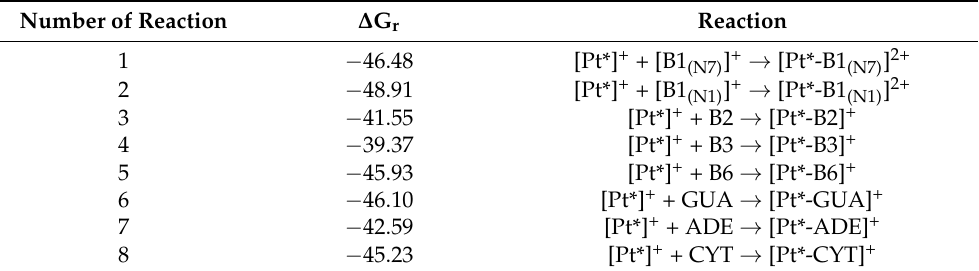
Table 2. The energetic characteristics of the Pt-Chloroaqua reactions with vitamin B and nucleobases obtained at the MN15/def2-TZVP level of theory. All energies are given in kcal/mol. Symbol Pt* stands for